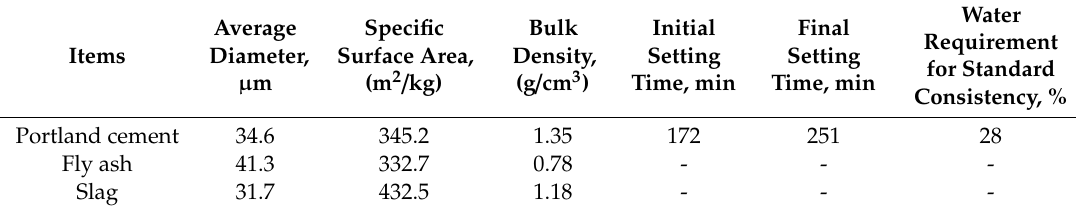
Table 2. Physical properties of cementitious